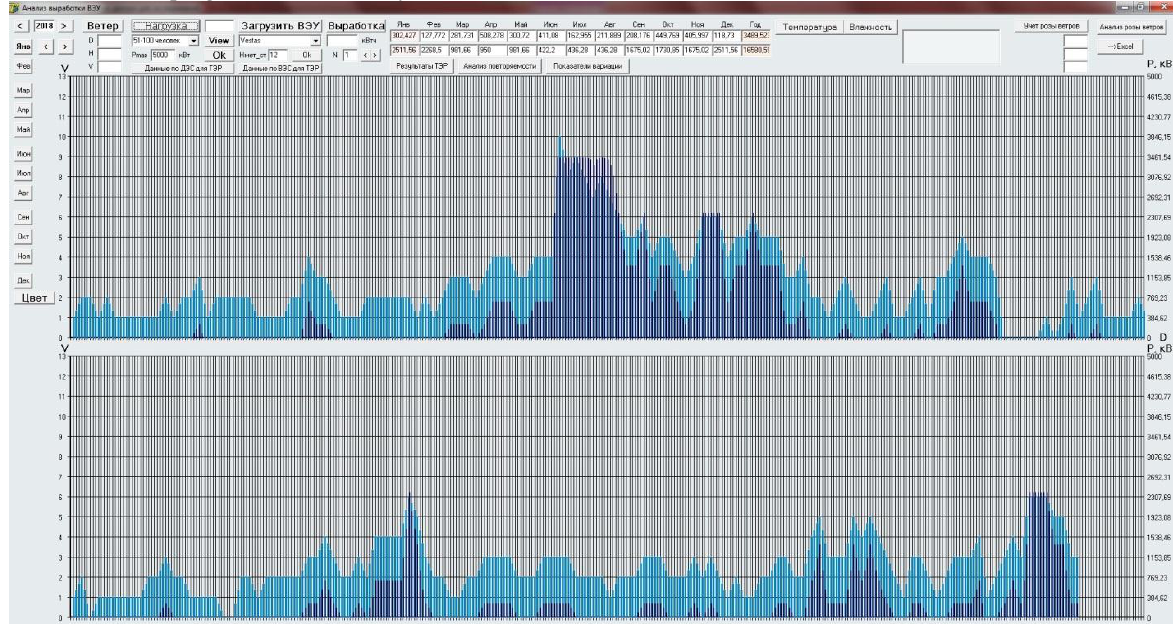
Fig. 1. Screenshot of the Wind-MCA program. Graphs of changes in wind speed (light blue lines) and power generation of wind turbine Vestas V126 4.5 MW (dark blue lines) in January 2018, Ulyanovsk.